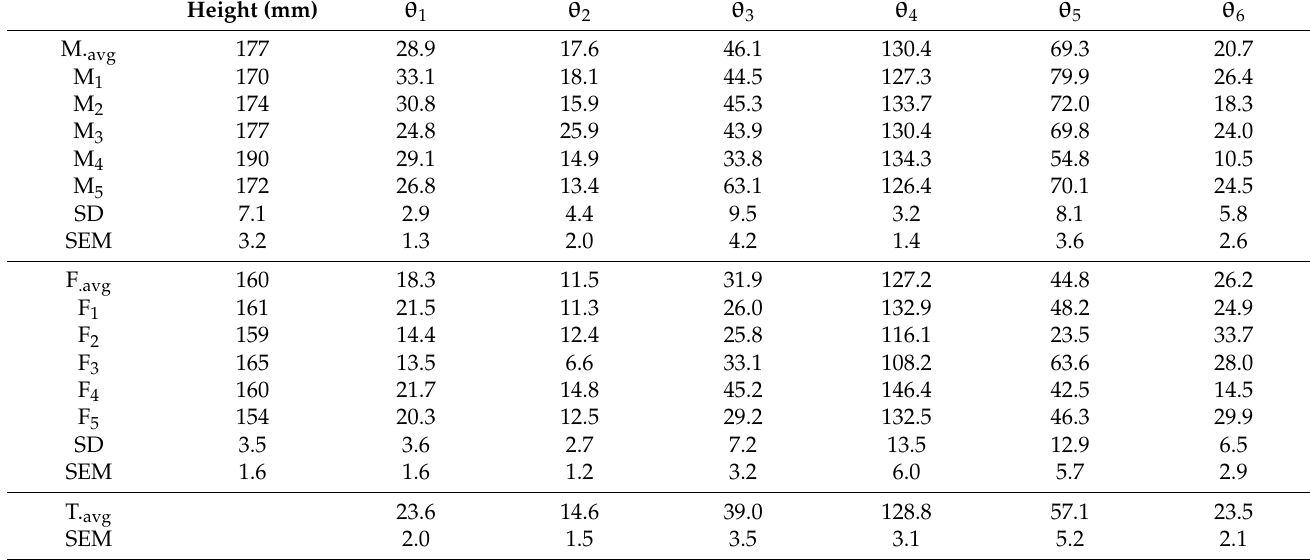
Table 2. Data collection for ROM ( ◦ ) for males and females (abduction and